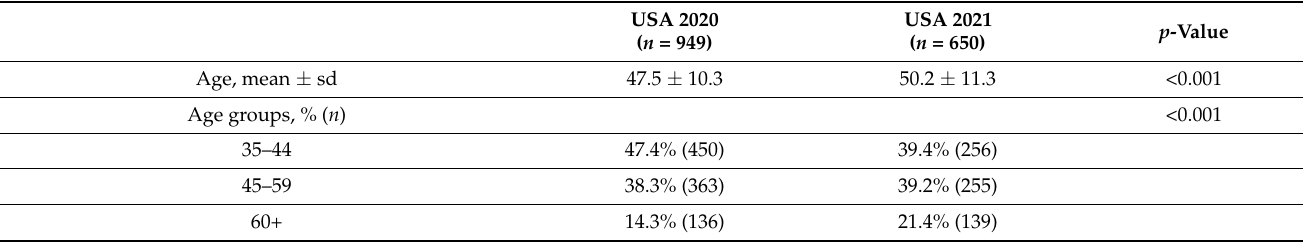
Table A1. Comparison of USA respondents to surveys conducted in January 2020 and in June